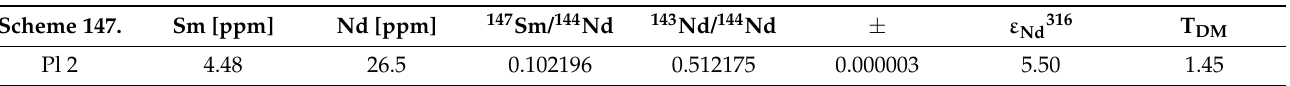
Table 6. Whole-rock Rb-Sr and Sm-Nd isotopic composition of the Pl 2 microgranite. T DM calculated according to Liew and Hofmann [50]